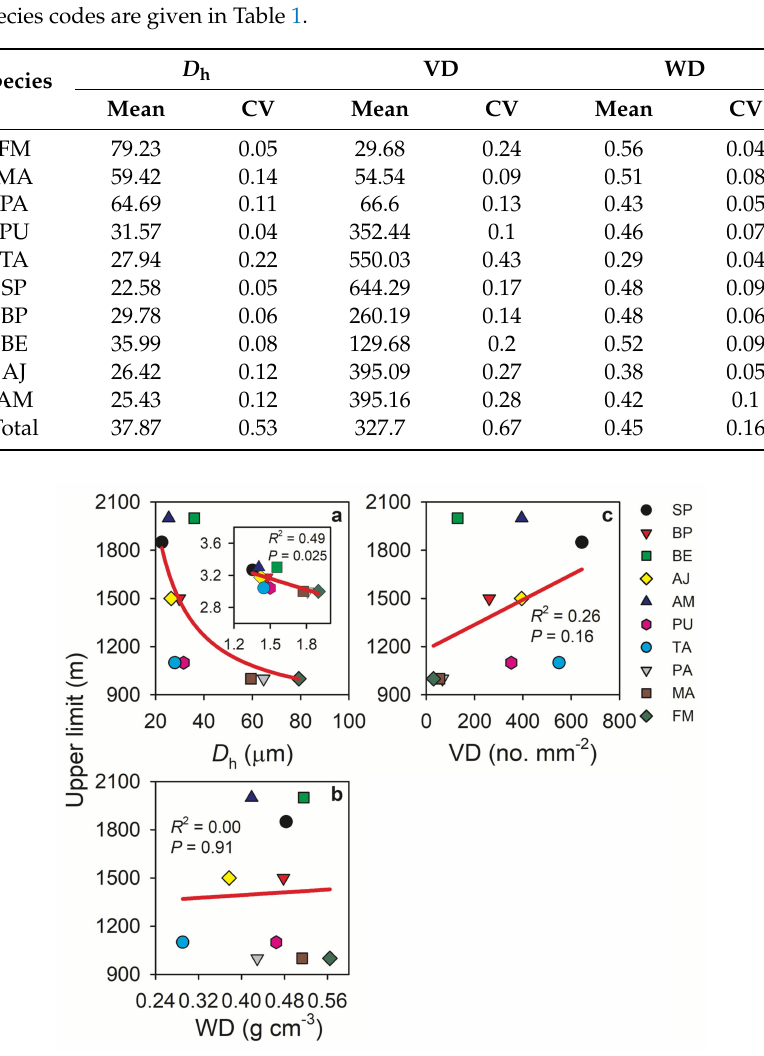
Table 3. The mean values and intraspecific coe ffi cients of variation (CV) for the three studied functional traits in the 10 temperate deciduous tree species studied along the altitudinal gradient. hydraulically